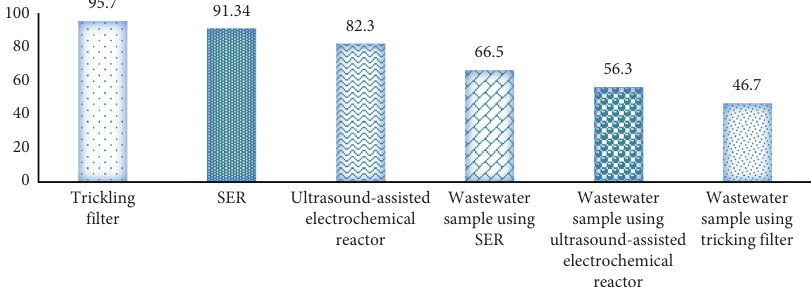
Figure 14: Comparison based on efficiency. Dye removal percentage using different